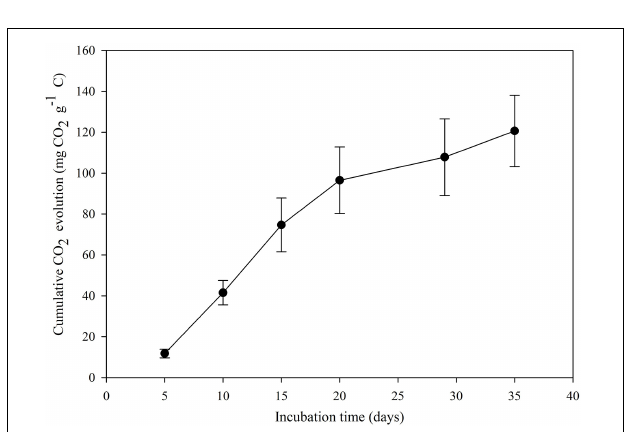
FIGURE 2 | Cumulative CO 2 evolution by bacterial strain during growth with